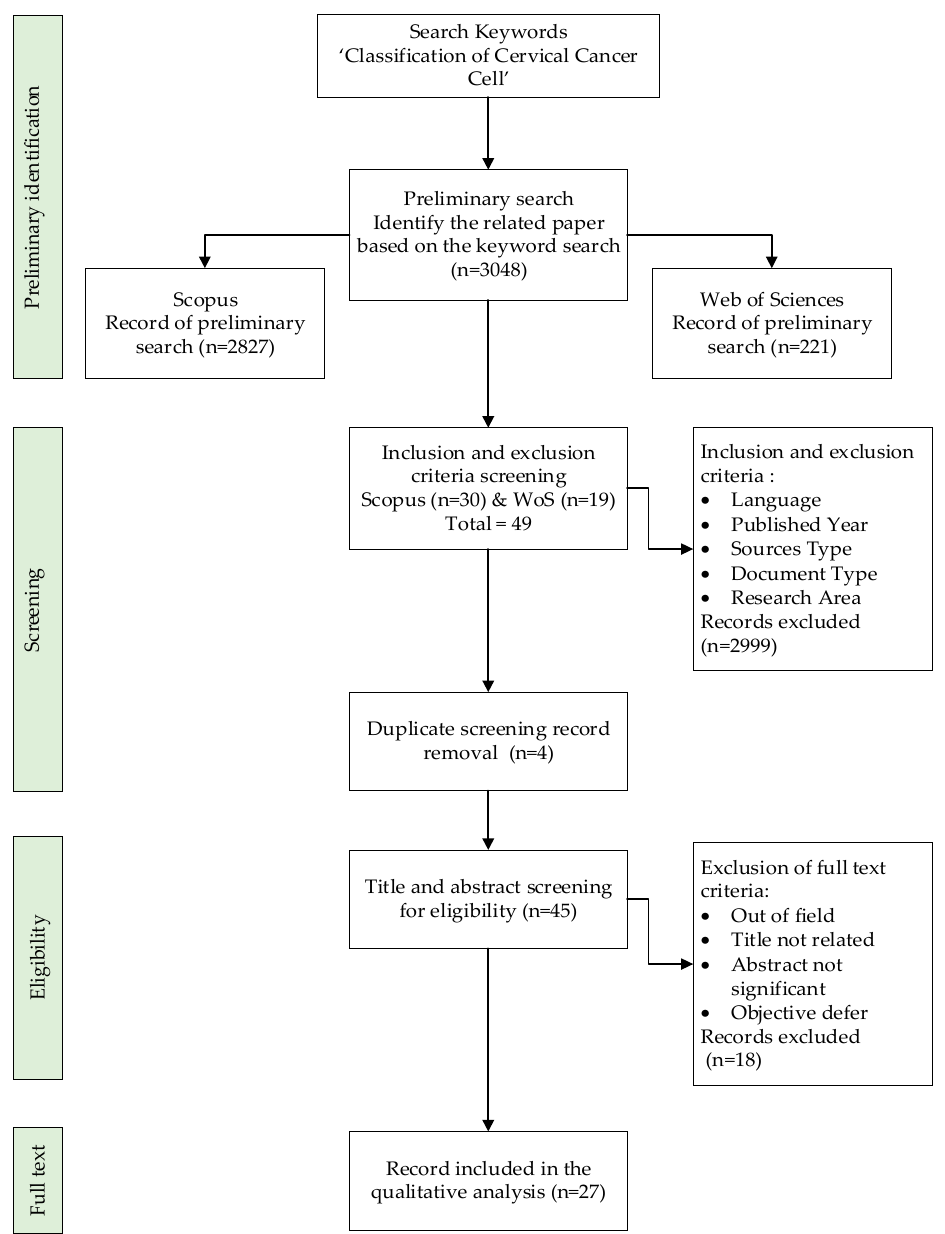
Figure 2. Flow diagram of the proposed advanced search study.